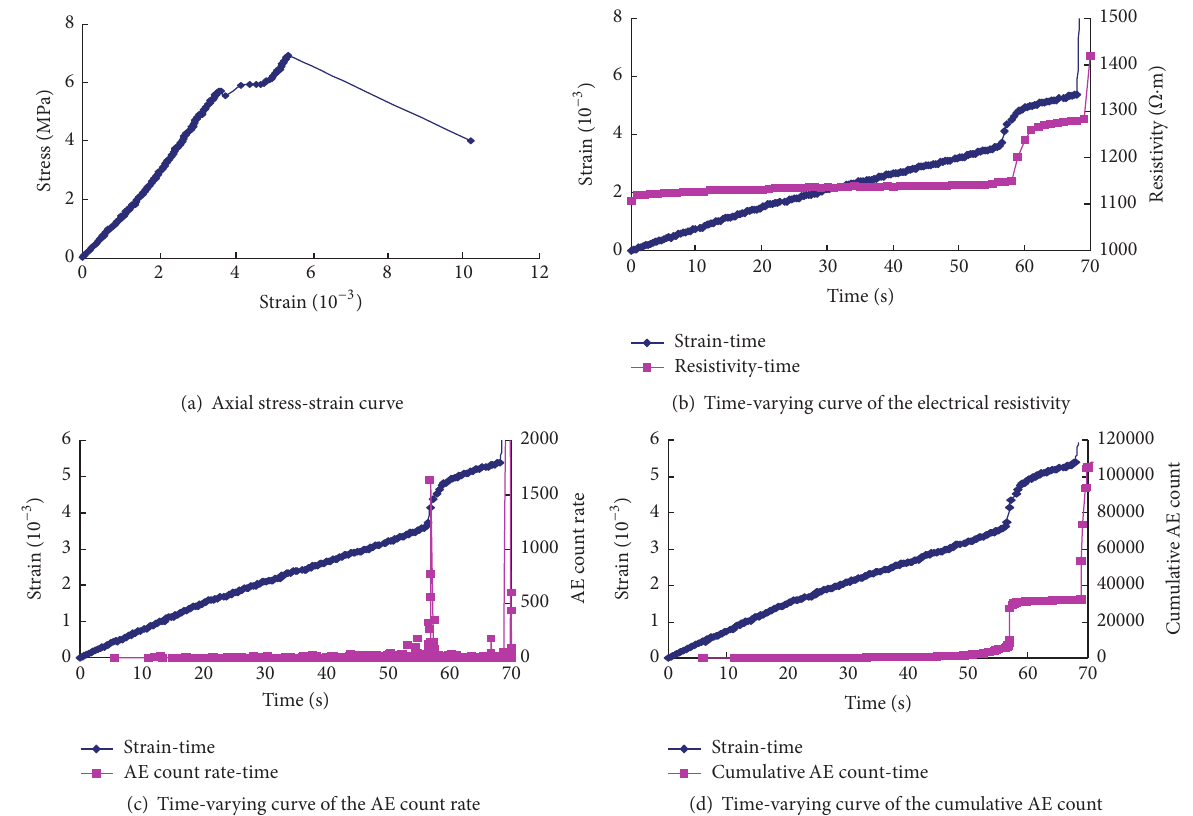
Figure 5: Test results of samples whose loading directions are parallel to the bedding